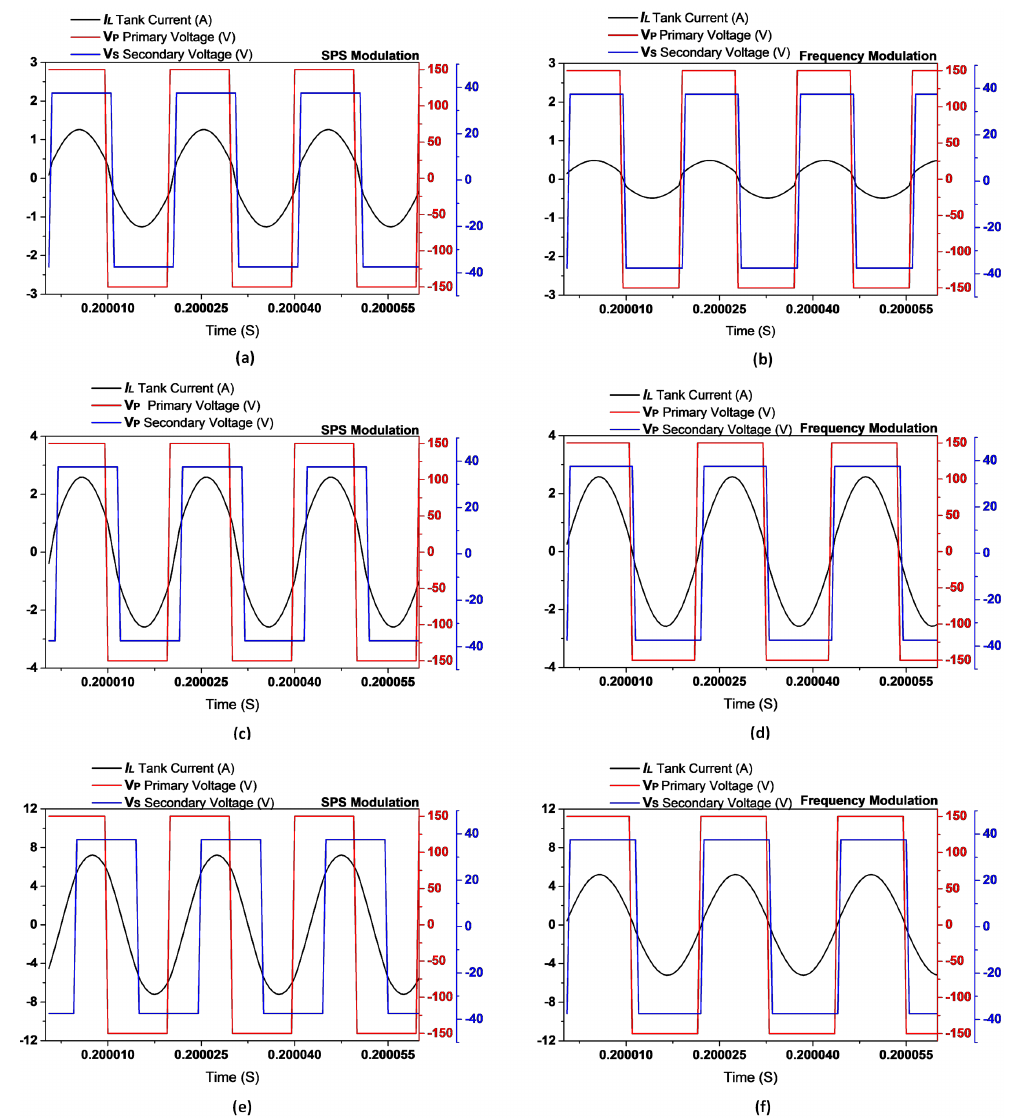
Figure 20. Simulated waveform at a voltage gain of M = 1: ( a ) 25% rated power using SPS modulation; ( b ) 25% rated power using frequency modulation; ( c ) 50% rated power using SPS modulation; ( d ) 50% rated power using frequency modulation; ( e ) 100% rated power using SPS modulation; ( f ) 100% rated power using frequency modulation. Table 1. Specifications of the